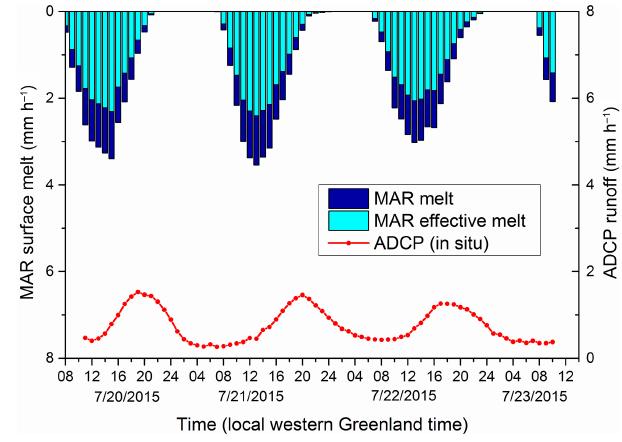
Figure 2. Within the Rio Behar catchment, MAR regional climate model inputs of melt (at top) are paired with in situ acoustic Doppler current profiler (ADCP) outputs of supraglacial river discharge (at bottom) to calibrate the unit hydrograph (UH) surface routing mod- els assessed in this study. “Effective melt” is the fraction of total MAR melt production that is transported all the way to the Rio Be- har IDC terminal outlet moulin (Smith et al., 2017). The UH is cal- culated using effective melt as input and observed runoff as output as per Smith et al.